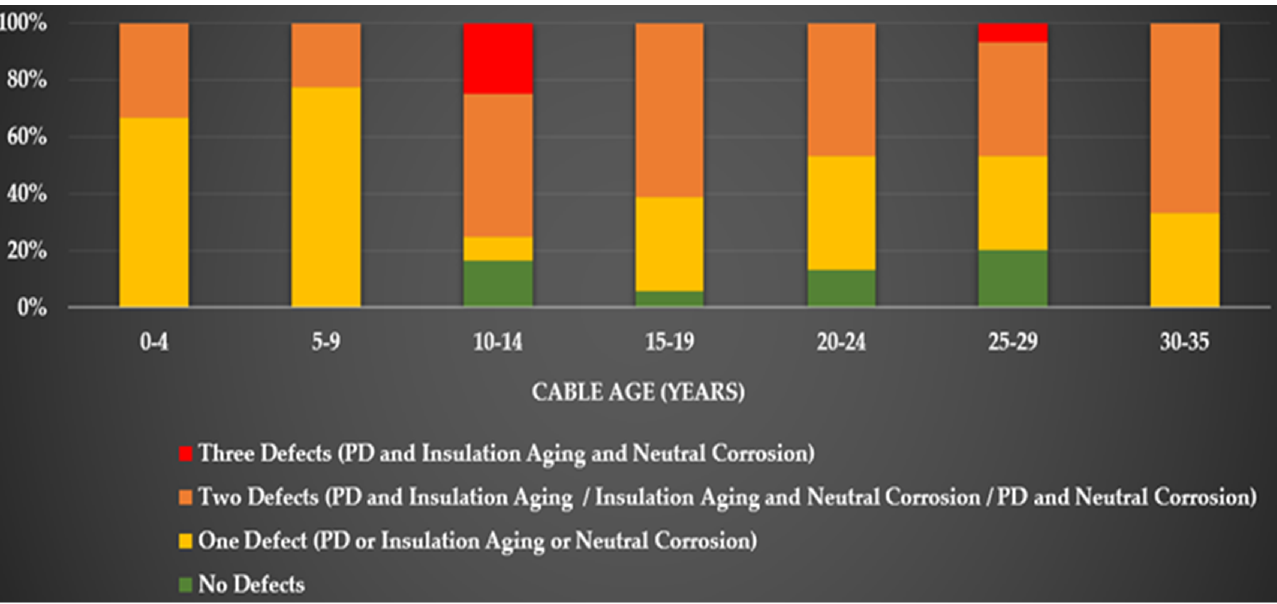
Figure 8. Sample distribution of defect types as a function of cable system age (25 kV, 750 MCM, Cu, TRXLPE/XLPE, direct buried, and jacketed).